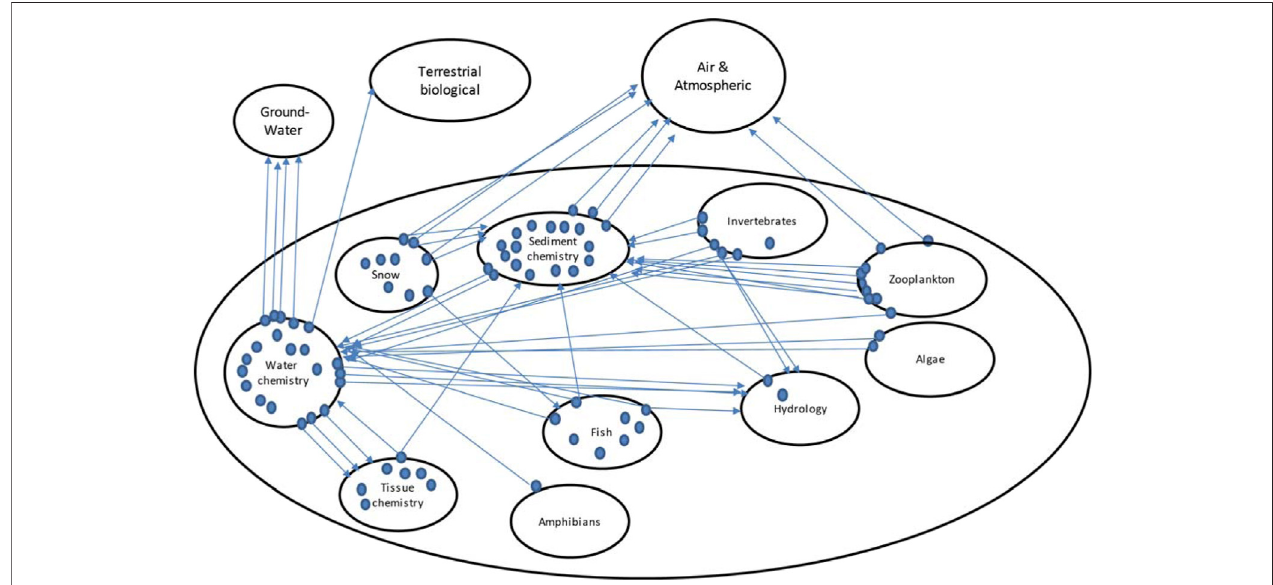
FIGURE 5 | Linkages between studies appearing in the peer-reviewed literature from 2009 – 2020; blue circles indicate a study reporting the results of a given oval; arrows from blue dots showing linkages, either explicit or implicit, within a study to another relevant result; shows few linkages of water programs to other theme areas within the OSM program; List of source papers included as Supplemental